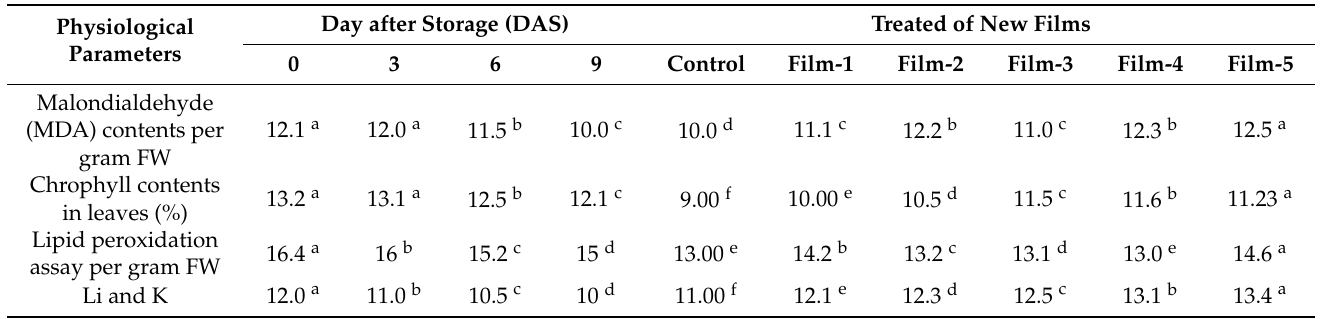
Table 9. Comparisons (DAS and new films) of physiological parameters of